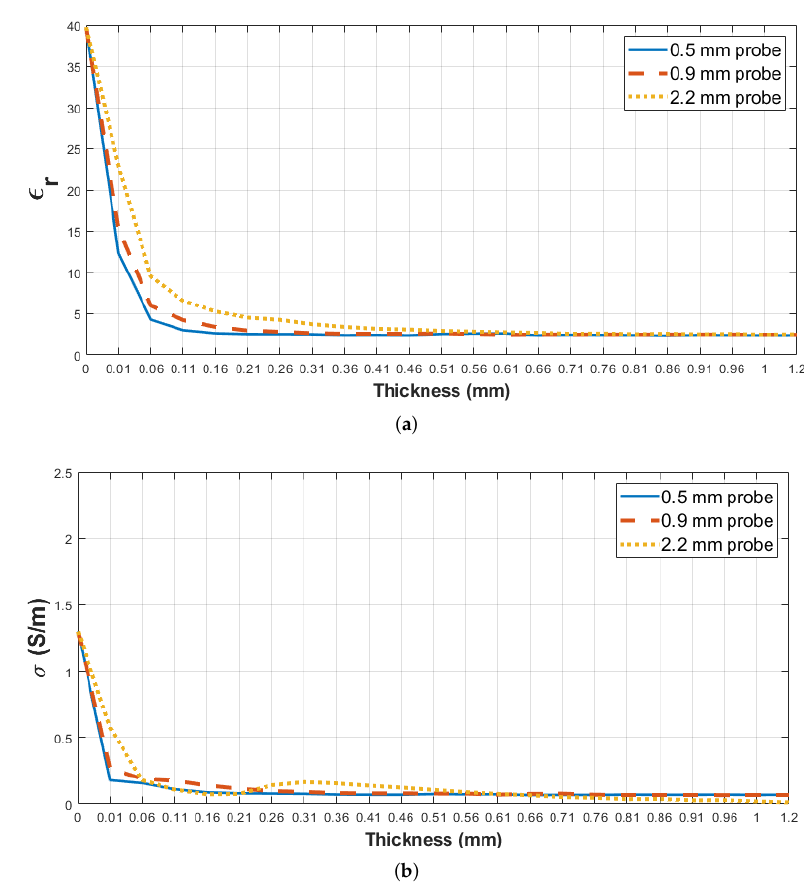
Figure 4. Retrieved dielectric property changes obtained from the simulated skin phantoms–olive oil liquids with 0.5, 0.9 and 2.2 mm probes: ( a ) retrieved relative permittivity change and ( b ) retrieved conductivity change as a function of second layer thickness (d) below the probe tips at 4